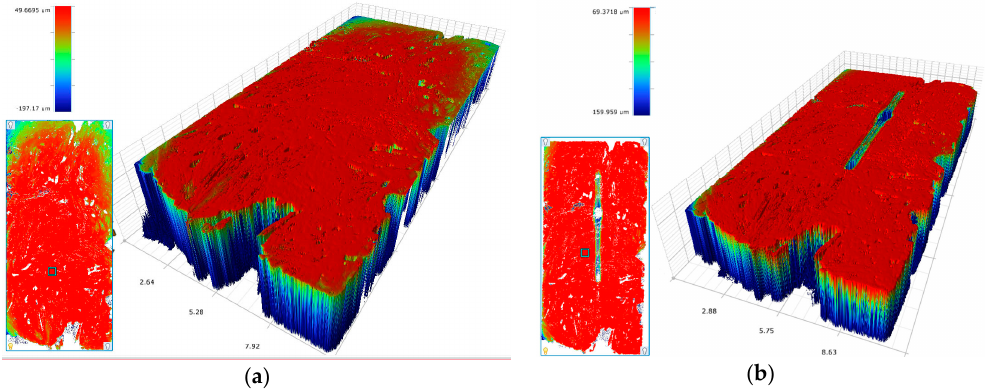
Figure 4. White-light interferometric images of sample surfaces before ( a ) and after ( b ) the wear mark [19].